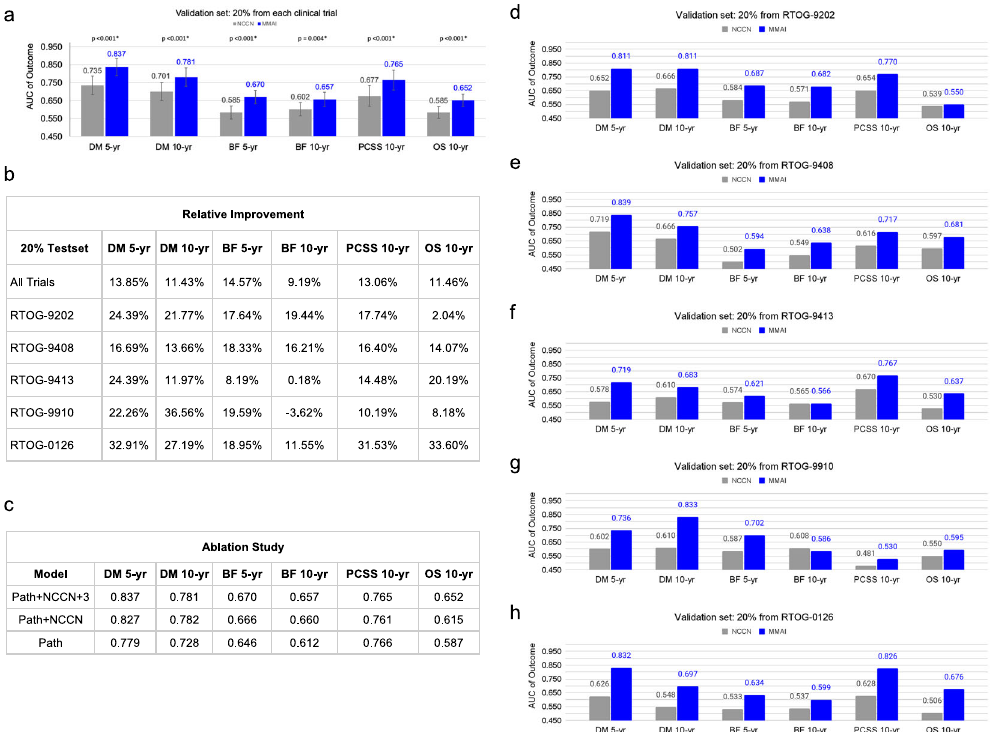
Fig. 3 Comparison of the multimodal deep learning system to NCCN risk groups across trials and outcomes. a Performance results reporting on the area under the curve (AUC) of time-dependent receiver operator characteristics of the MMAI (blue bars) vs. NCCN (gray bars) models, include 95% con fi dence intervals and two-sided p -values. Comparisons were made across 5-year and 10-year time points on the following binary outcomes: distant metastasis (DM), biochemical failure (BF), prostate cancer-speci fi c survival (PCSS), and overall survival (OS). b Summary table of the relative improvement of the MMAI model over the NCCN model across the various outcomes and broken down by performance on the data from each trial in the validation set. Relative improvement is given by (AUC MMAI − AUC NCCN )/AUC NCCN . c Ablation study showing model performance when trained on a sequentially decreasing set of data inputs, including the pathology images only (path), pathology images + NCCN variables (path + NCCN), and pathology images + NCCN variables + age + Gleason primary + Gleason secondary (path + NCCN + 3). d – h Performance comparison on the individual clinical trial subsets of the validation set — together, these fi ve comprise the entire validation set shown in ( a